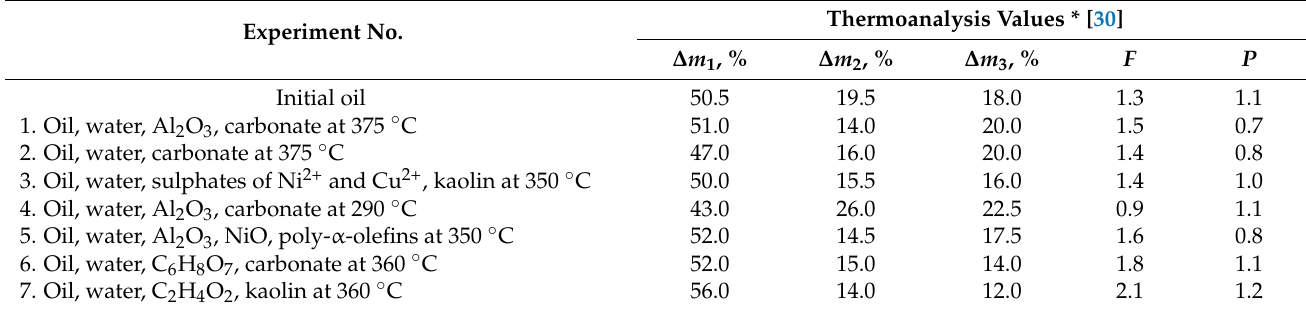
Table 5. Thermal analysis data of the original and converted